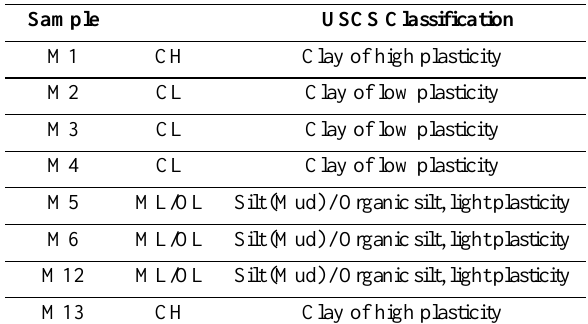
Table 1. USCS Classification of the specimens.